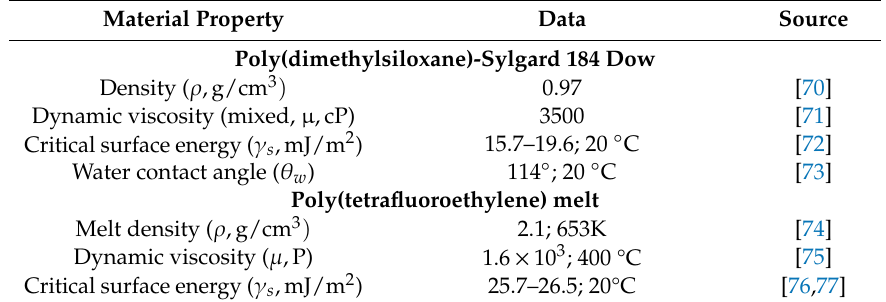
Table A1. Relevantmaterialpropertiesofpoly(dimethylsiloxane)elastomerandpoly(tetrafluoroethylene)melt.